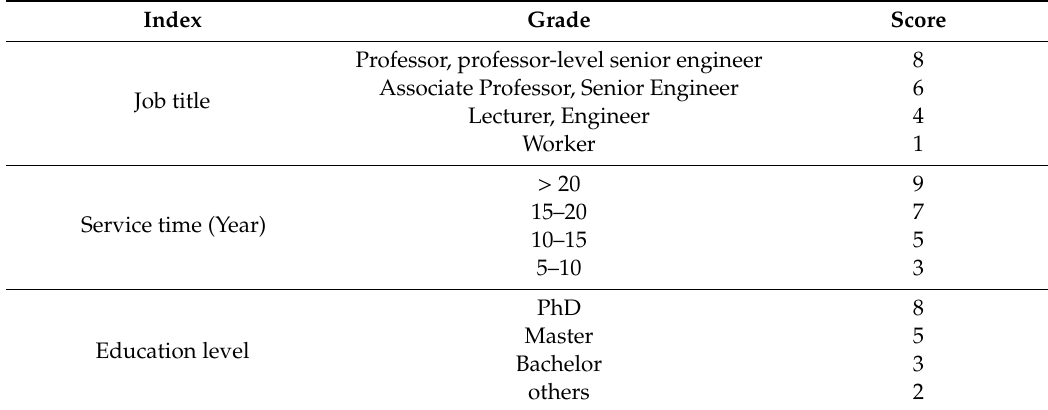
Table 1. Experts score table.